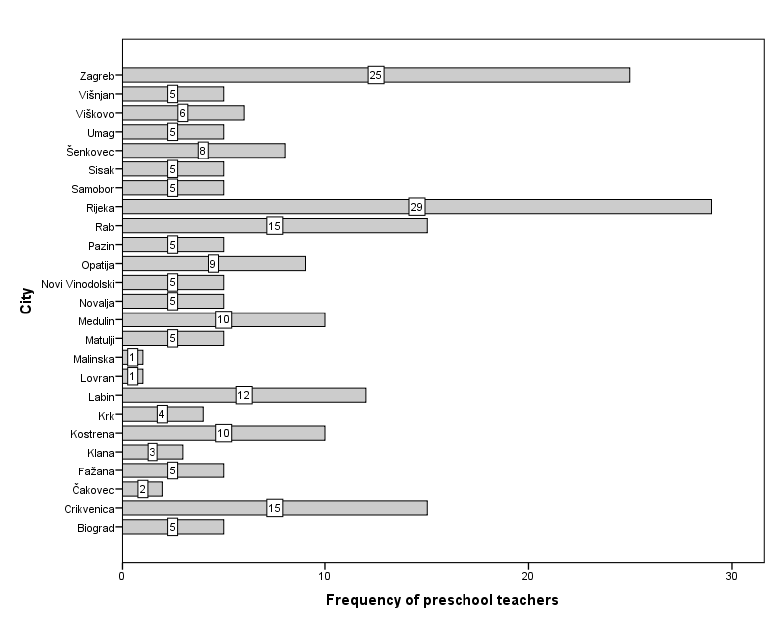
Figure 1 : Bar chart of the frequency of preschool teachers by each city from six